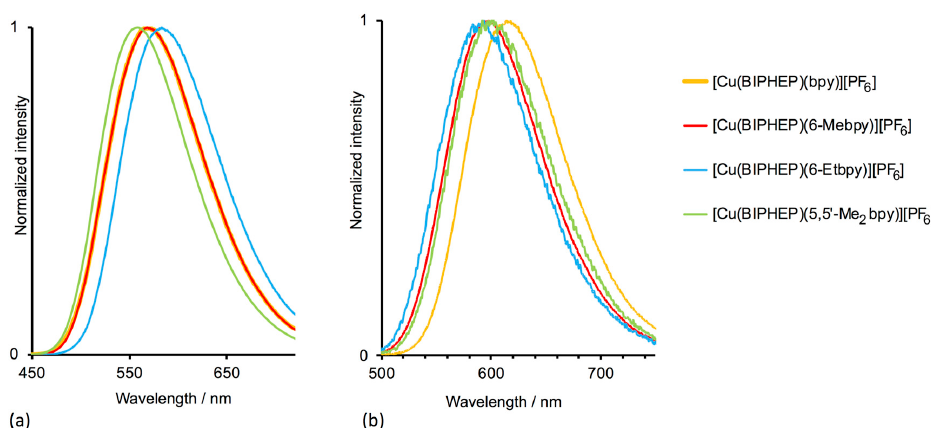
Figure 9. ( a ) Normalized emission spectra of the powdered [Cu(BIPHEP)(N^N)][PF 6 ] compounds, λ exc = 365 nm. The curves for [Cu(BIPHEP)(bpy)][PF 6 ] and [Cu(BIPHEP)(6-Mebpy)][PF 6 ] are virtually superimposed. ( b ) Normalized emission spectra of the [Cu(BIPHEP)(N^N)][PF 6 ] complexes in frozen Me-THF at 77 K. λ exc = 410 nm.